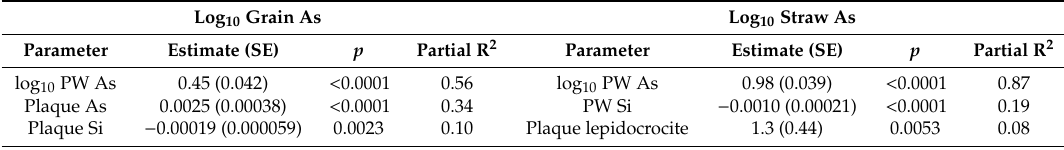
Figure 11. Relations between concentrations of As in polished rice grain and oxalate-extractable ( A – C ) Fe or ( D ) Mn in bulk soil in the field study. Table 1. linear regression models for grain and straw